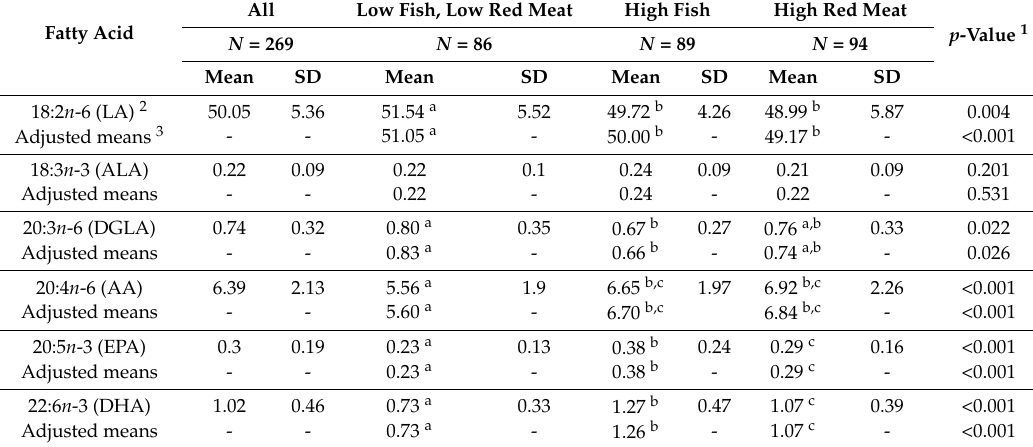
Table 2. Plasma fatty acid composition (weight %) of 269 Singapore Prospective Study Program participants with high red meat, high fish, or low red meat and fish consumption. All Fatty Acid